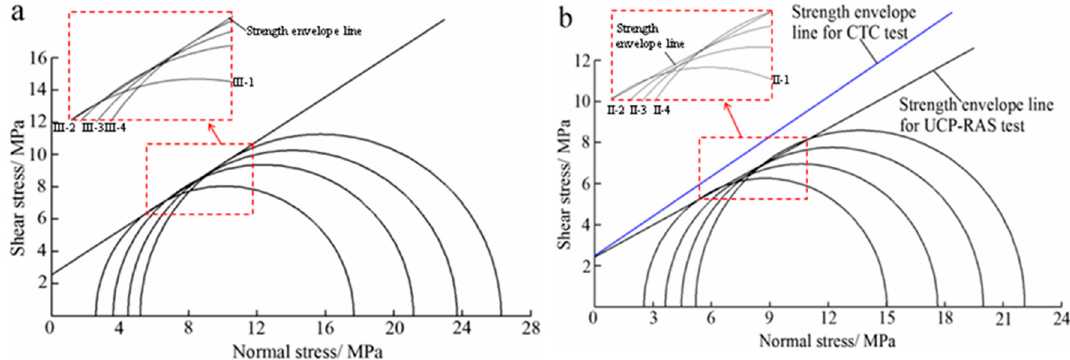
Figure 13. Mohr’s stress circle of coal specimens: ( a ) under the CTC test; ( b ) under the UCP-RAS